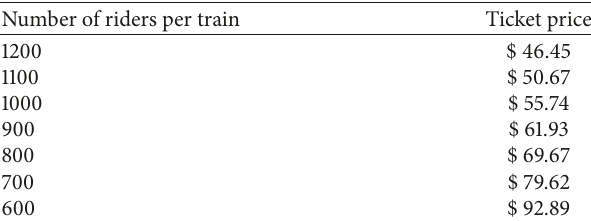
Table 5: Expected ticket prices to ride the mass transit system based on total ridership. Number of riders per